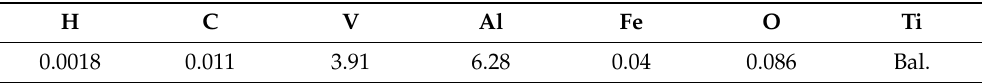
Table 1. Chemical composition of Ti-6Al-4V alloy powder